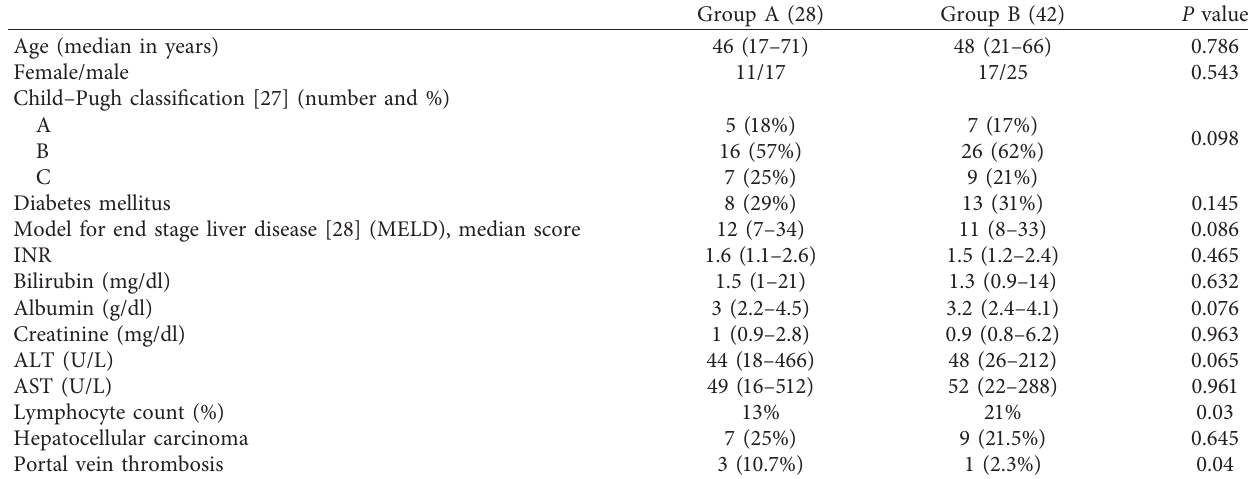
Table 1: Demographic and laboratory characters of the studied group.